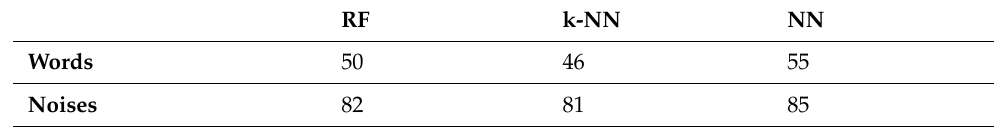
Table 1. Dataset prediction accuracies (%).